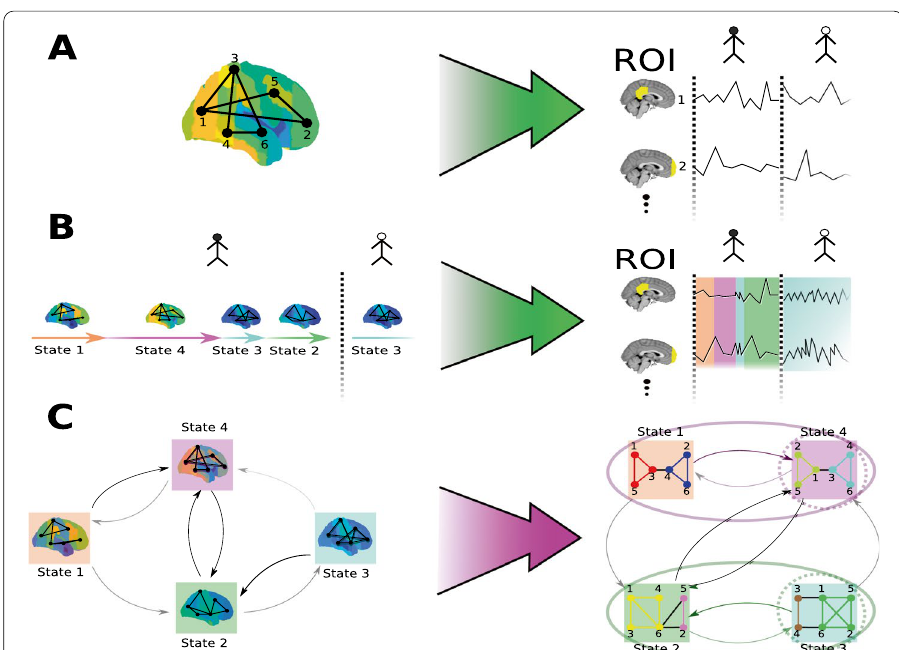
of weakly stationary segments (right). Segment colour indicates the state that generated it. In C we use temporal relationships between states to represent the system as a dynamic multiplex graph. This system